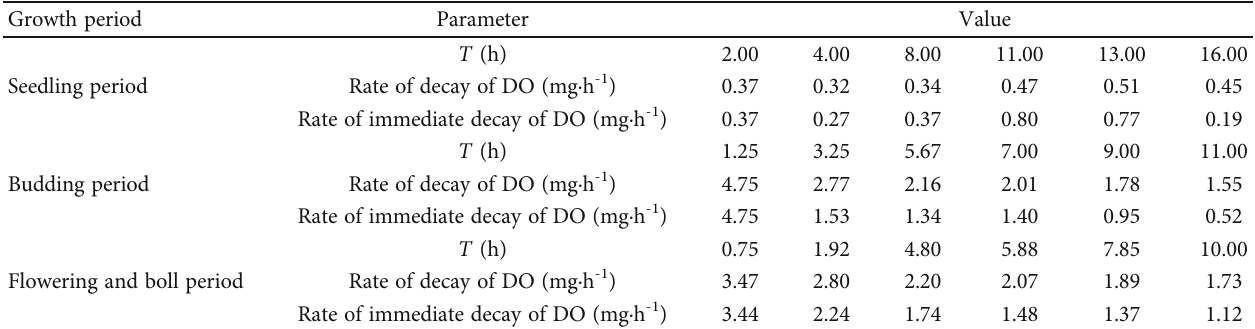
Table 2: Statistical data of oxygen consumption rate per cotton plant in di ff erent periods.